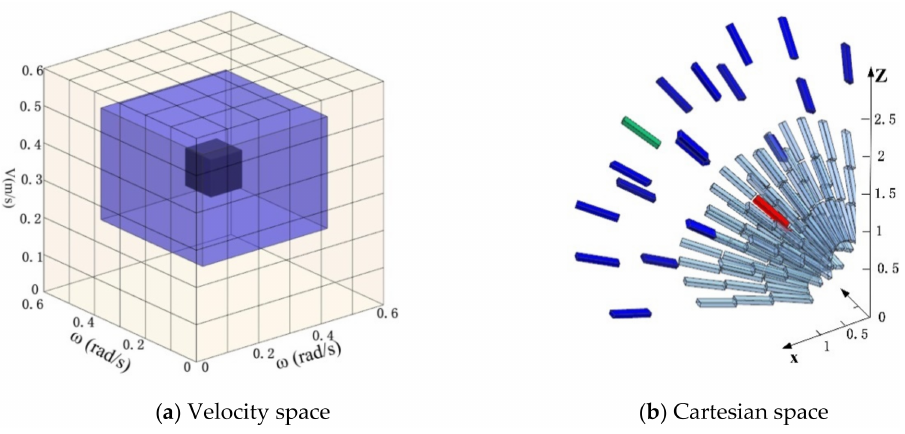
Figure 3. Two-level ( a ) velocity space and ( b ) Cartesian space.